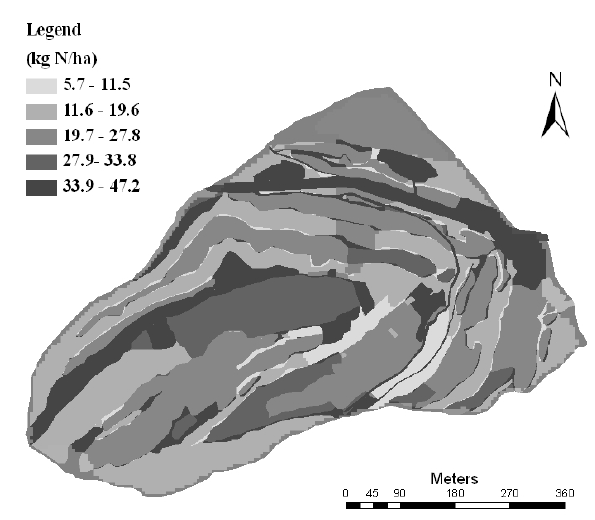
Fig. 4. The spatial distribution of the annual total N loss rate in the Yanting watershed. The N loss rate for the residential regions was based on local